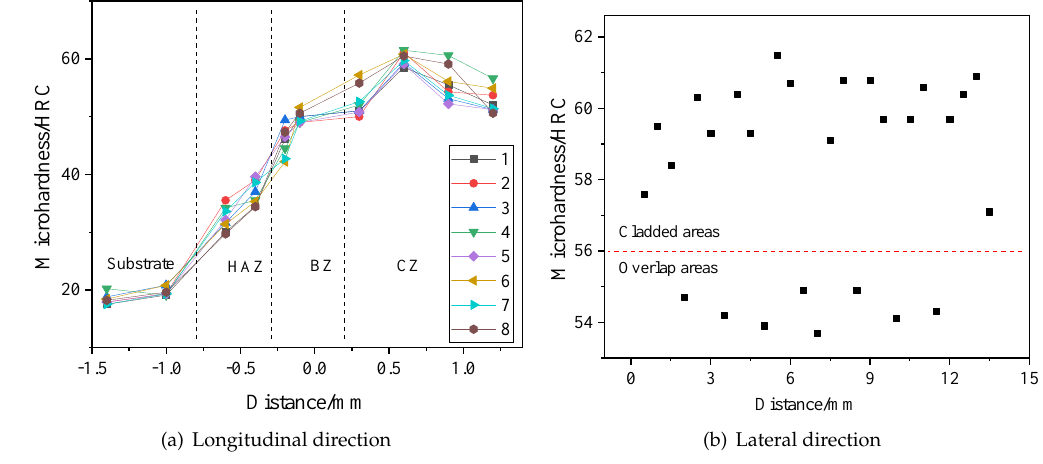
Figure 11. Microhardness of cladding